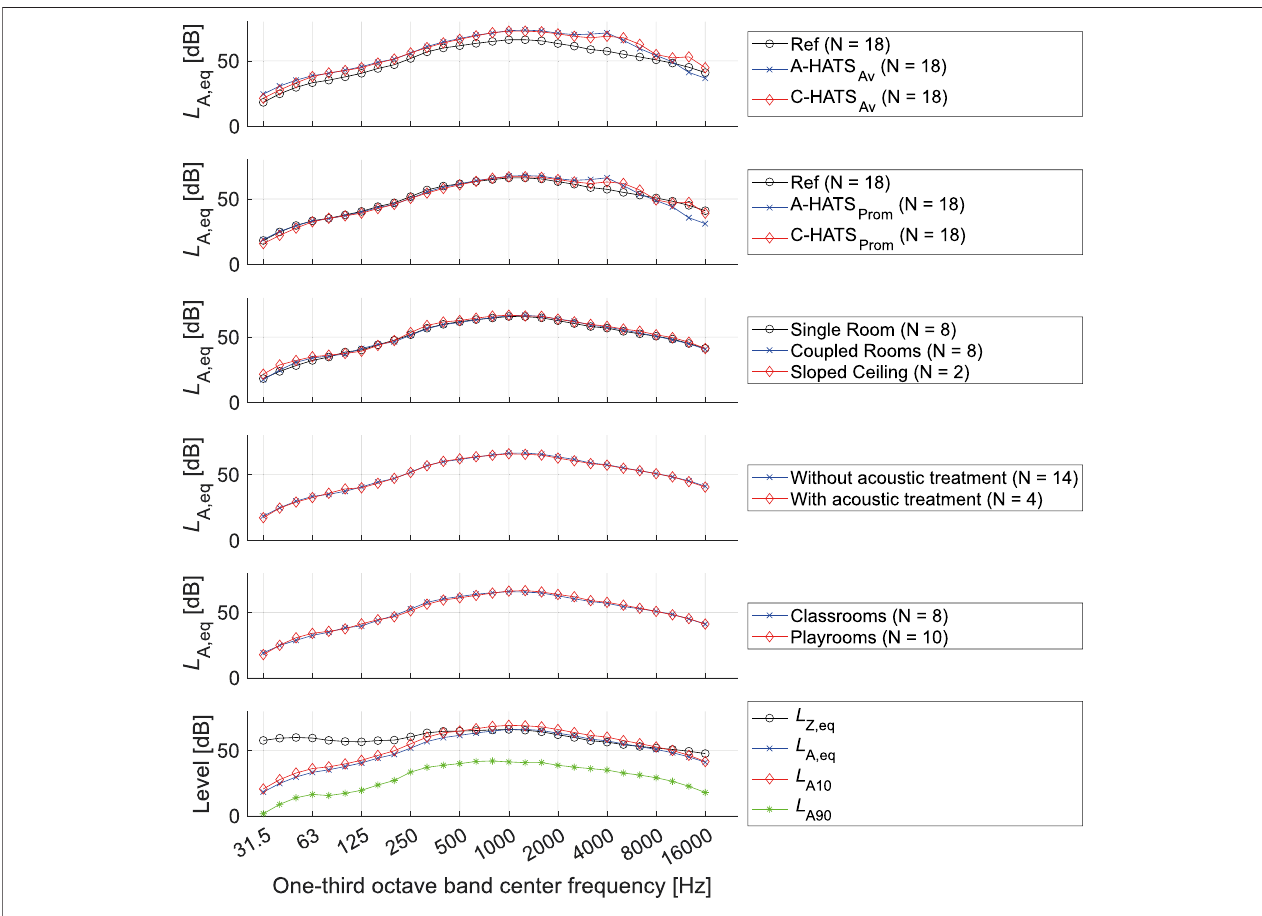
FIGURE 5 | One-third octave band sound pressure levels (A-weighted) for the measurement methods and various room properties. Here, Ref = omnidirectional microphone, A-HATS Av /C-HATS Av = adult/child HATS (level summation), and A-HATS Prom /C-HATS Prom = adult/child HATS (prominent-ear method).